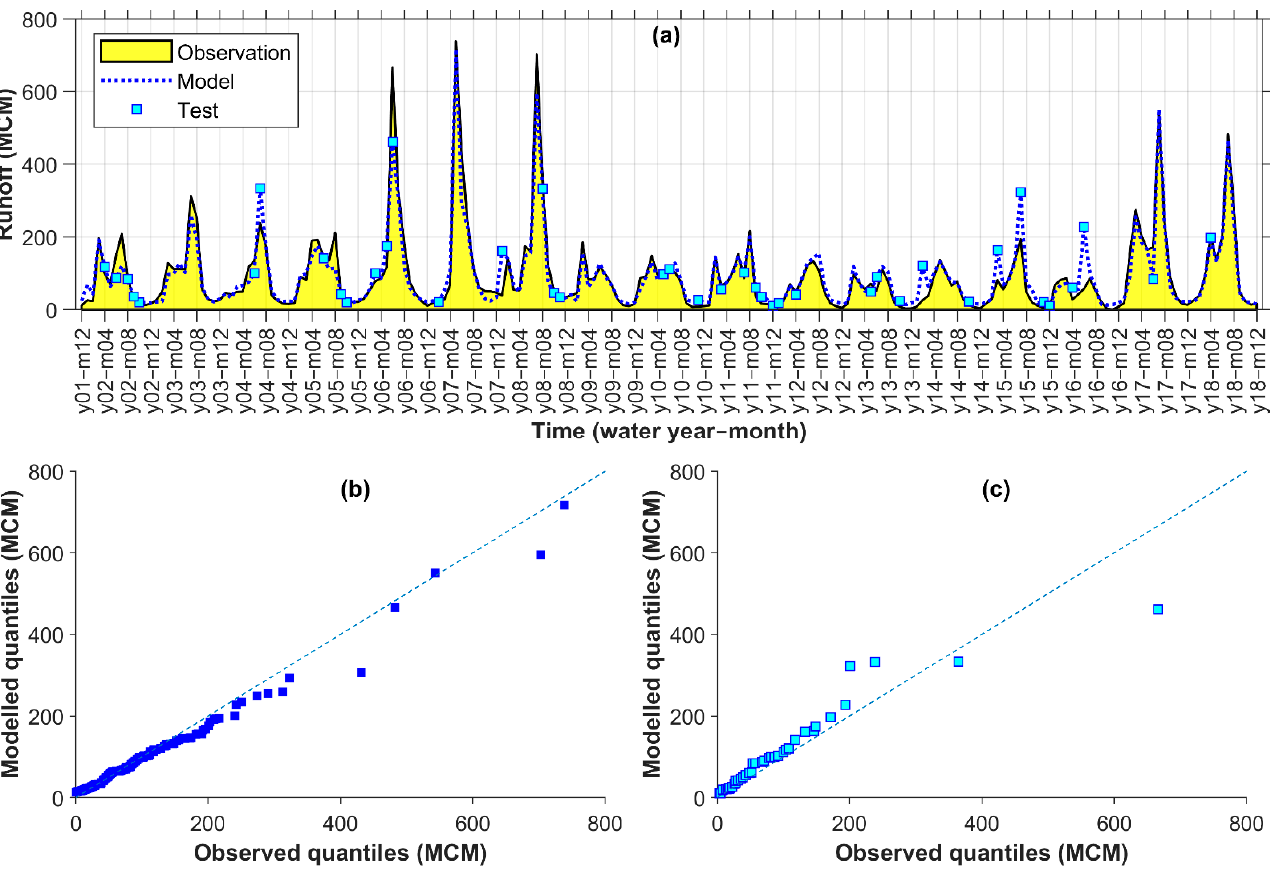
Figure 7. Kashkan observed vs. modelled monthly runoff time series ( a ) and q–q plots for calibration ( b ) and test ( c ) points (MCM: million cubic meters). Table 8. Performance criteria values for the selected (Comb. 7 Lag 0–1) vs. reference model (Comb. 5 Lag 0–1) in testing points for Kashkan (RMSE and MAE are in million cubic meters while the others are unitless) and the change rate (%) between